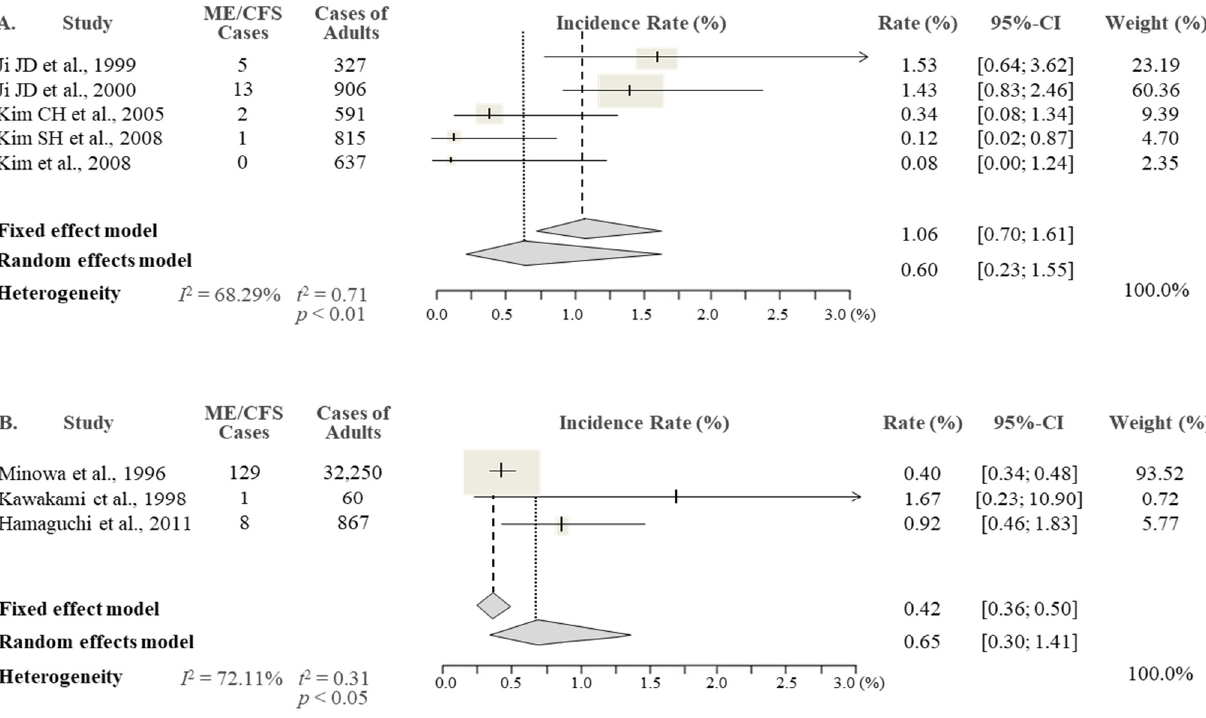
Figure 3. Meta-analysis of the ME/CFS prevalence in males in Korea ( A ) and Japan ( B ).